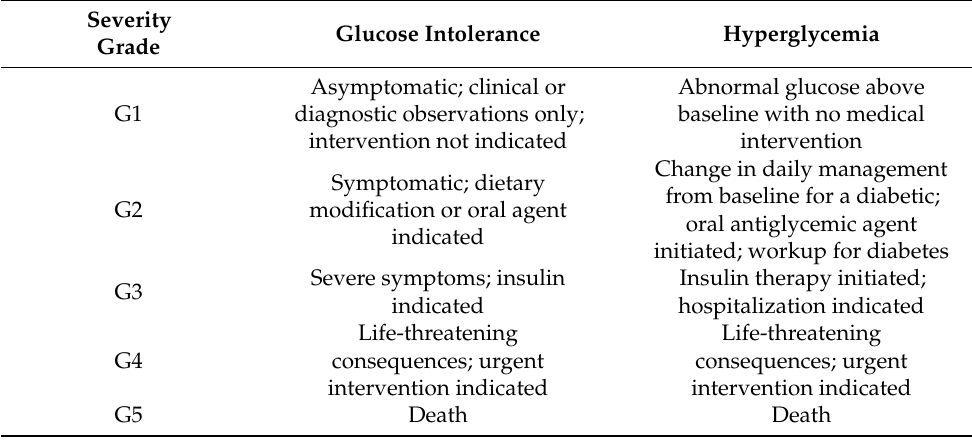
Table 2. Common Terminology Criteria for Adverse Events: glucose intolerance and hyperglycemia.